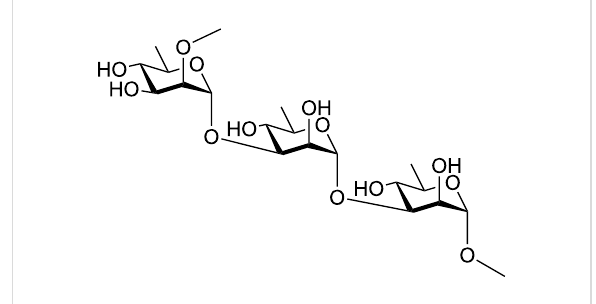
Figure 1: Repeating unit of the A-band polysaccharide of P. aerugi- nosa.